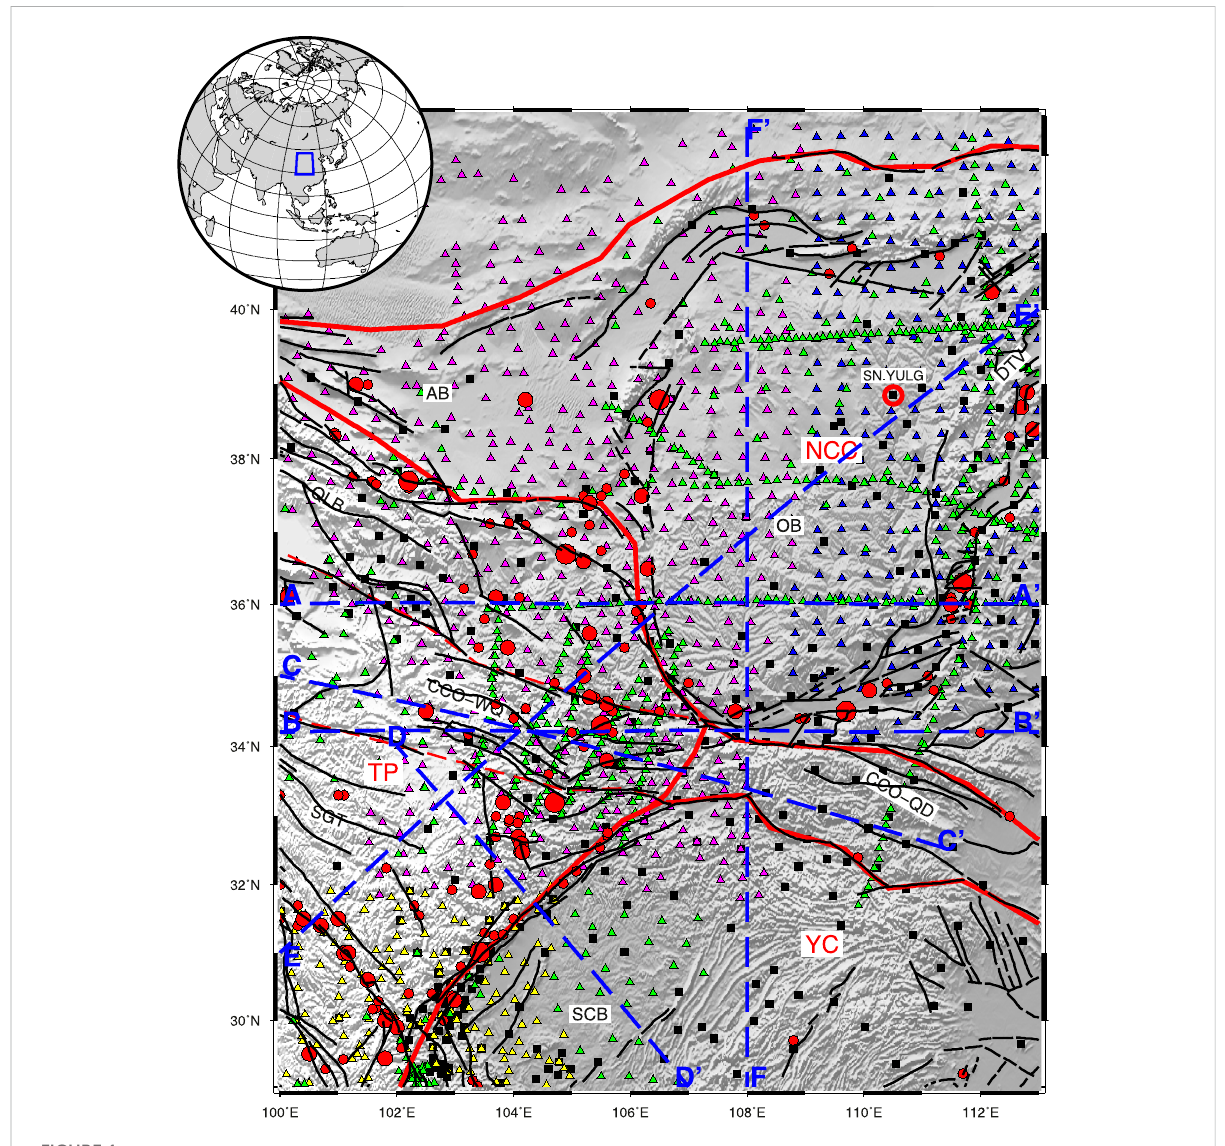
FIGURE 1 Distribution of seismic stations and regional tectonic units (revisedfrom Zhao et al., 2005). Black squares: permanent stations, Yellow triangles: western Sichuan array, Red triangles: ChinArray-Himalaya Phase Ⅱ , Blue triangles: ChinArray-Himalaya Phase Ⅲ , Green triangles: Other temporary stations. Red circles mark M ≥ 6 earthquakes, Blue dashed lines represent sections. and Black lines and red dashed lines represent faults and tectonic boundaries, respectively. TP: Tibetan plateau; YC: Yangtze Craton; CAOB: Central Asia Orogenic Belt; NCC: North China Craton; SGT: Songpan-Garze Terrane; QLB: Qilian tectonic belt; OB: Ordos Block; AB: Alxa Block; CCO: Central China Orogen (or Qinling tectonic belt); WQ: Western Qinling; QD: Qinling